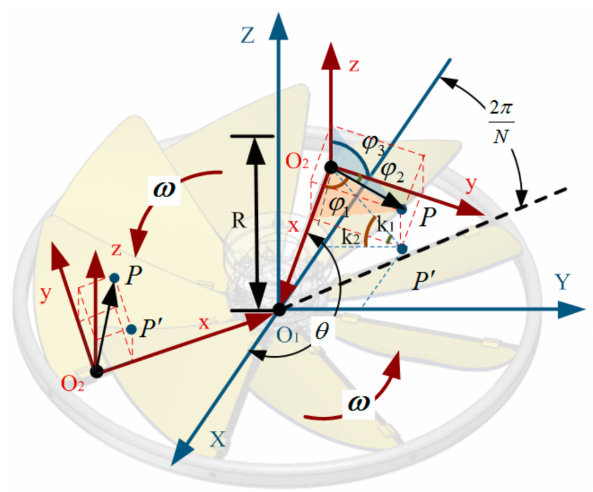
Figure 12. Kinematic characteristics of single-layer absorber and its blades.